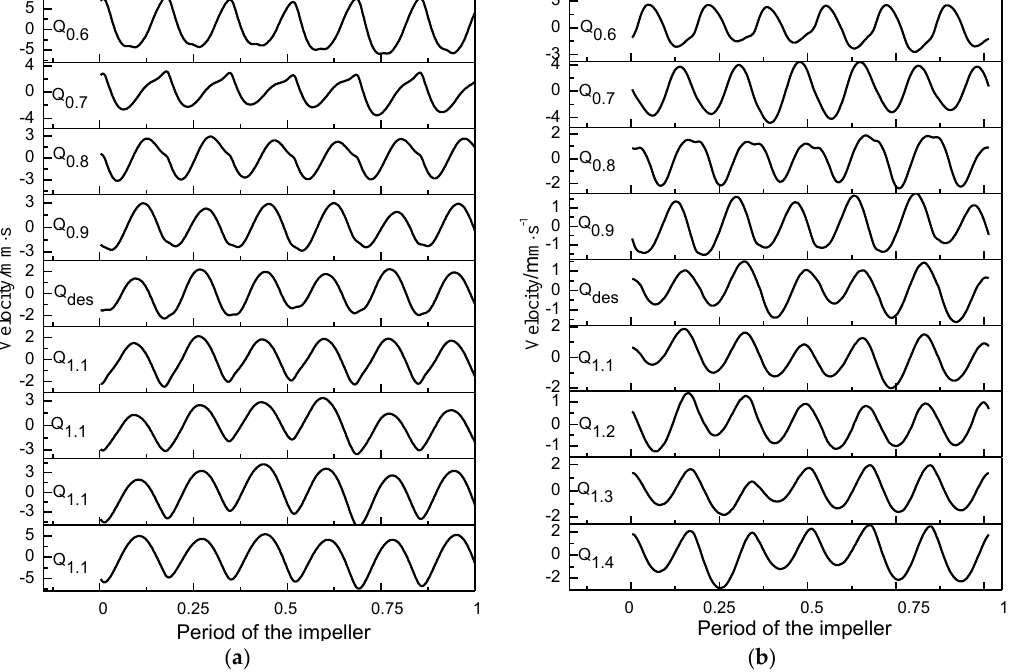
Figure 22. Time-varying velocity under different flow conditions: ( a ) X direction; ( b ) Y direction.